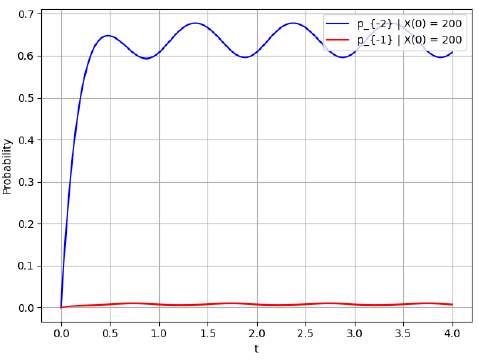
Figure 3. Probability F , R for t ∈ [ 0,4 ] and initial conditions X ( 0 ) = 200 and X ( 0 ) = 200, respectively.